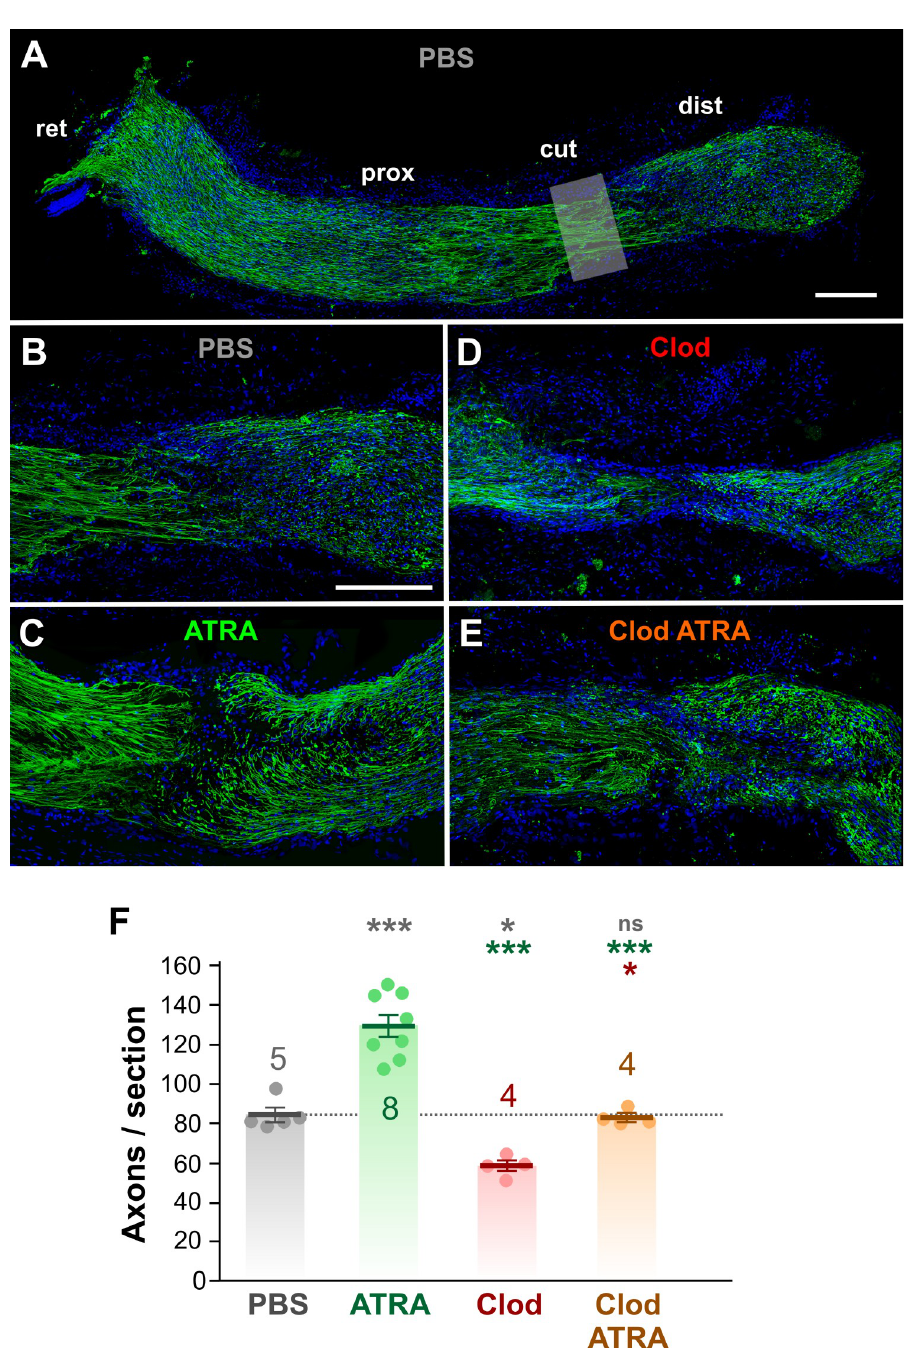
Fig 8. Regenerating axons are increased by ATRA and decreased by clodronate. (A—E) Confocal images of immunohistochemical staining of growing axons with anti-GAP43 antibody (green), in longitudinal sections of the optic nerve at 2 weeks after axotomy. Nuclei are counter-stained with DAPI (blue). (A) Low magnification maximum intensity projection of the complete nerve from a PBS-treated animal, composited from several 12 μ m sections, with the retina (ret) on the left and the distal stump (dist) on the right. The cut site (cut) and proximal stump (prox) are also indicated. (B-E) Enlarged views of the cut zone and regenerating regions of nerves from animals with different treatments. (B) PBS treatment, composite from 2 sections (C) ATRA-treatment, single section (D) Clodronate liposome treatment, composite from 2 sections. (E) ATRA and clodronate liposome treatment, composite from 2 sections. Scale bar: 100 μ m in A and B. (F) Bar and scatter plots of the number of axons per transverse section, sampled at approximately 200 μ m distal to the cut site, showing mean ± SEM. Treatments are PBS alone, ATRA,